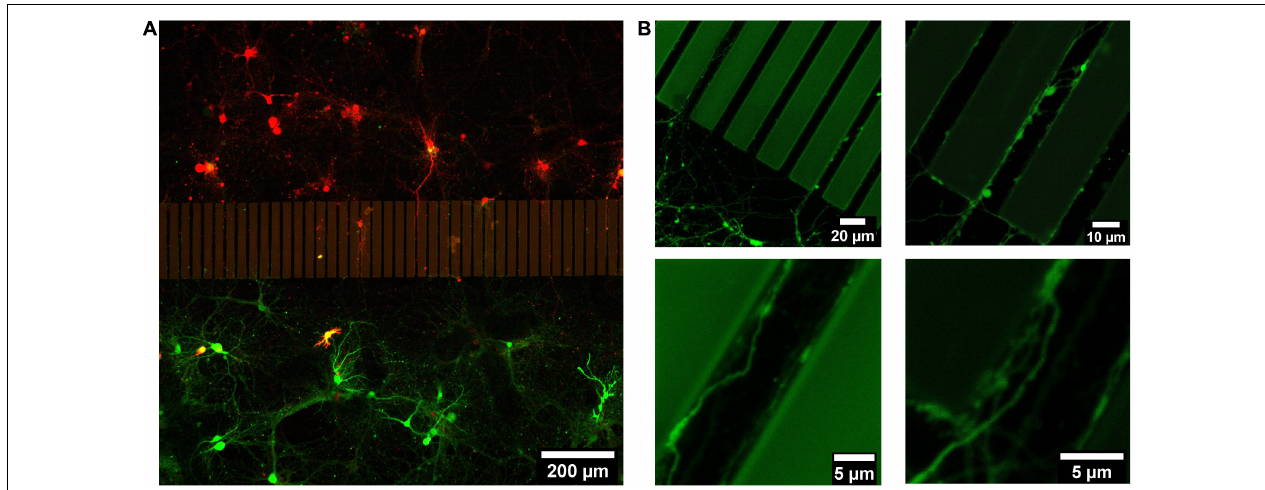
FIGURE 3 | Live imaging of 21 DIV postnatal hippocampal neurons growing on a structured and Poly-L-Lysine coated sapphire disk. (A) Two sets of postnatal hippocampal neurons labeled with mCherry and EGFP, respectively, which were growing in separated chambers. (B) Representative images of the neurites, which were growing in channels.